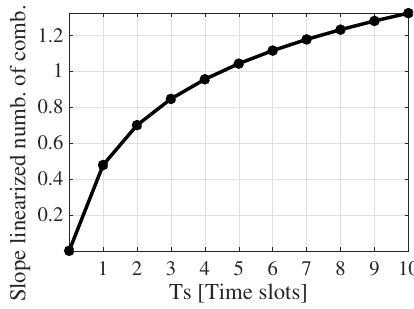
Figure 7. Example of growth rate of O PT T S based on T s . Parameter: T k s = { 0, · · · ,10 }